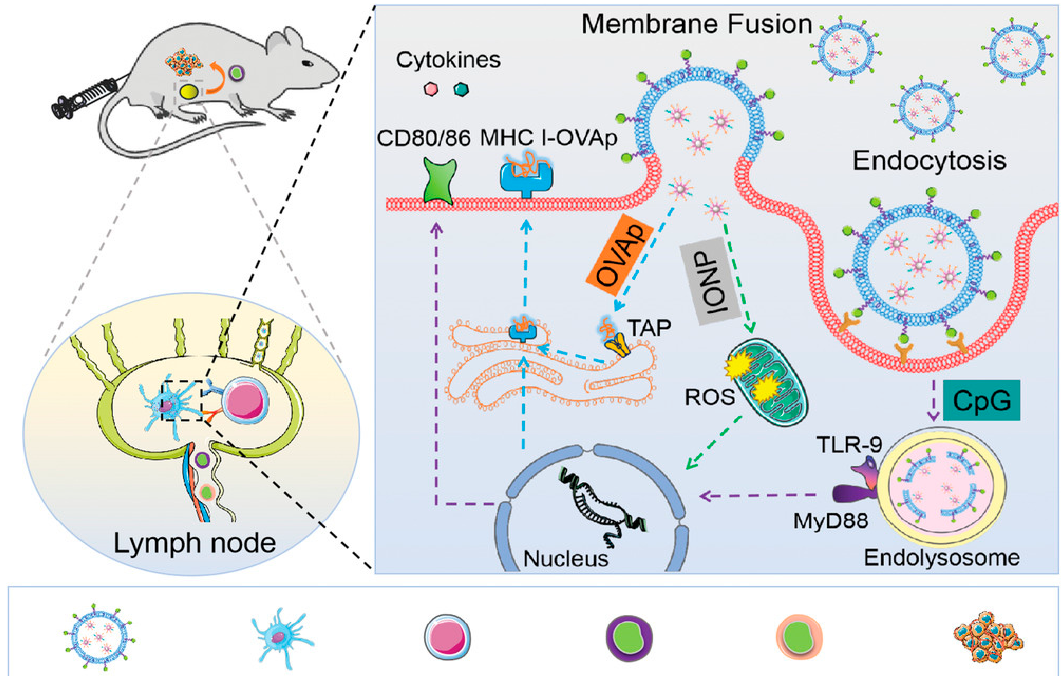
Figure 4. The synergistic effect and immune response elicited by IONP − C/O@LPs. IONPs co − delivered CpG DNA to active immature DCs, synergistically enhancing immune response and antitumor effect. Reprinted with permission from Ref. [97]. Copyright 2022, Wiley − VCH GmbH.